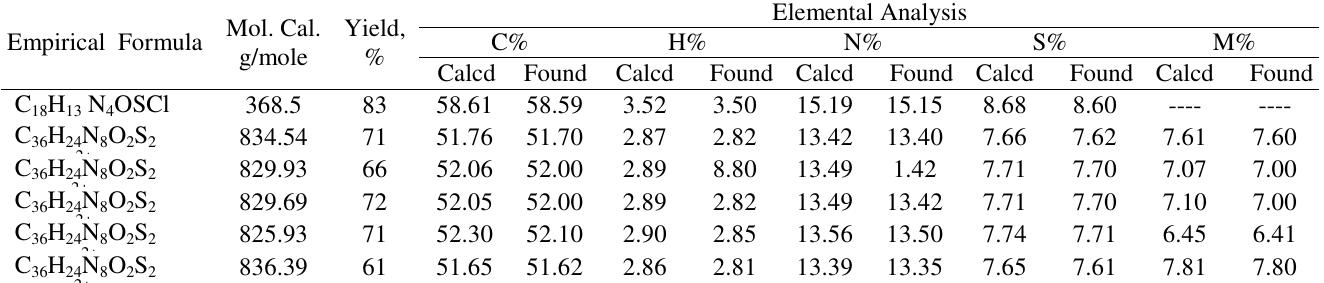
Table 1. Analysis of CTAQ ligand and its metal chelates.